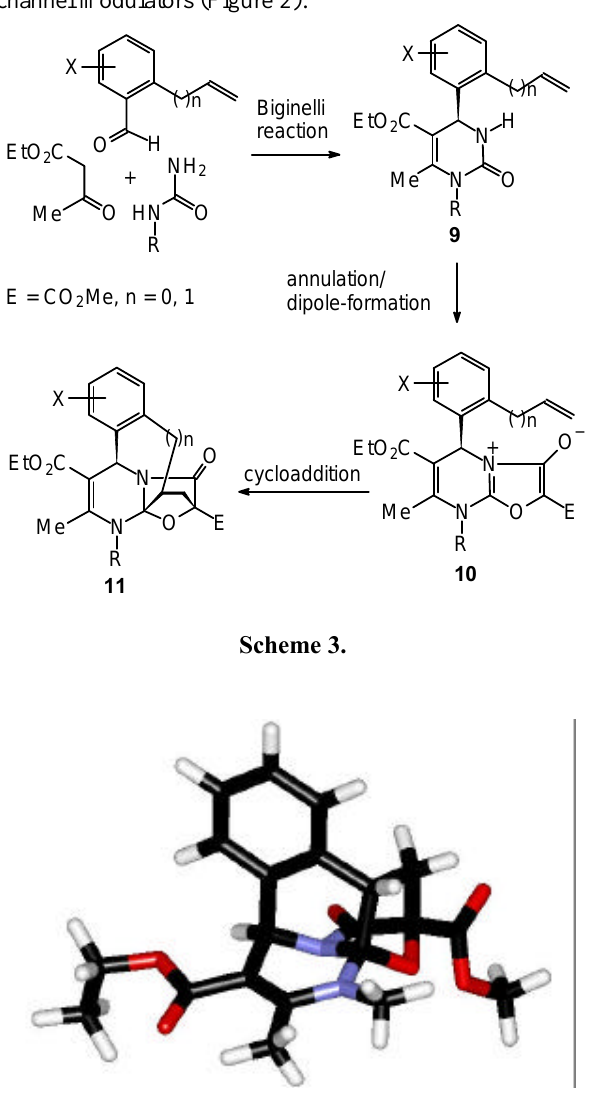
Figure 4. Solid-state structure of 11 (R = Me, X = H, n = 0)